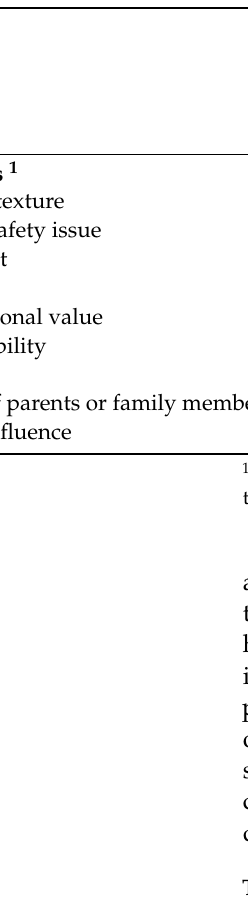
Table 4. Factors influencing the acceptance of grasshoppers and other insects as food according to study location and religion.